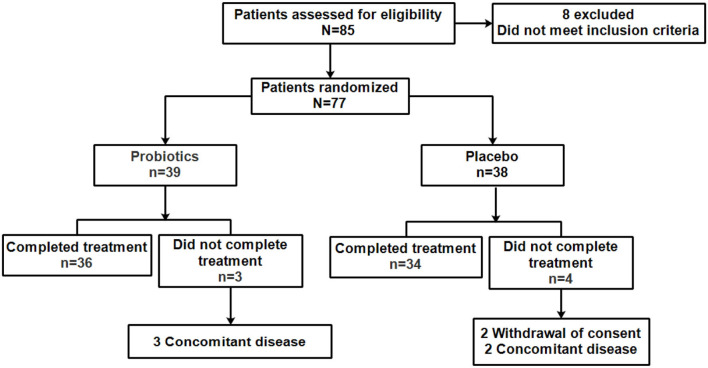
Patients included in the study.